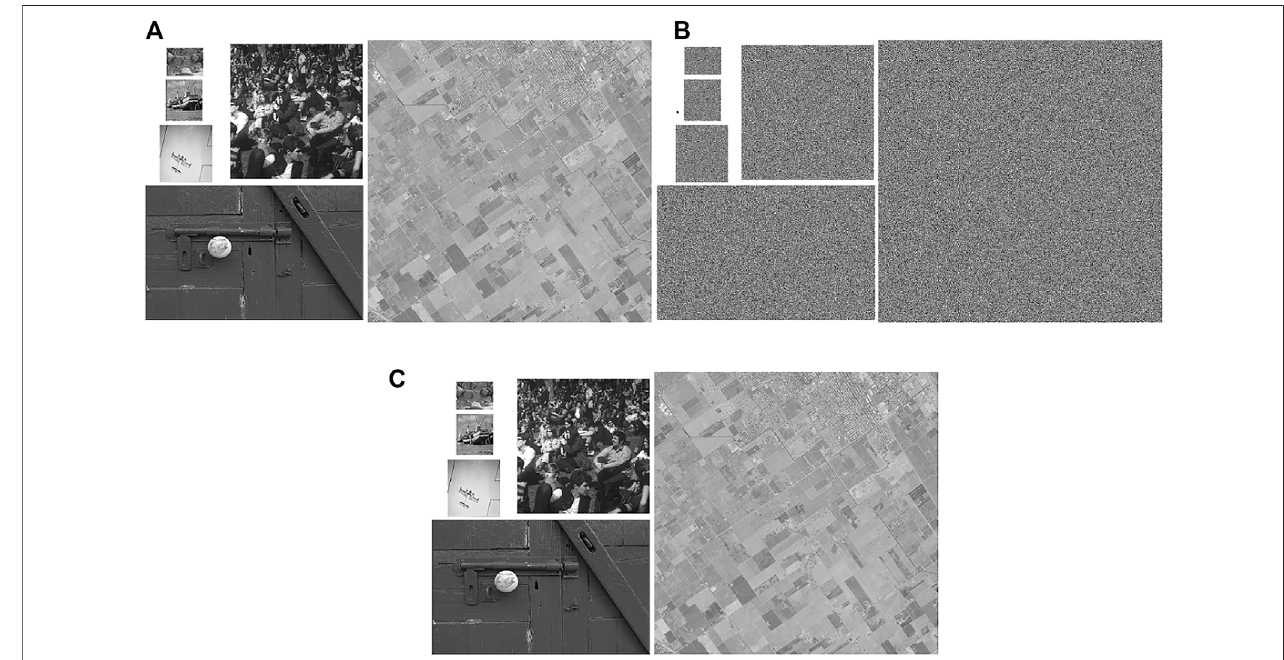
FIGURE 5 | Simulation results of 2D images (A) Plain images (Water, Boat, 5.1.11, Crowd, Kodimo2, 2.2.11) (B) Cipher images (C) Decrypted images.